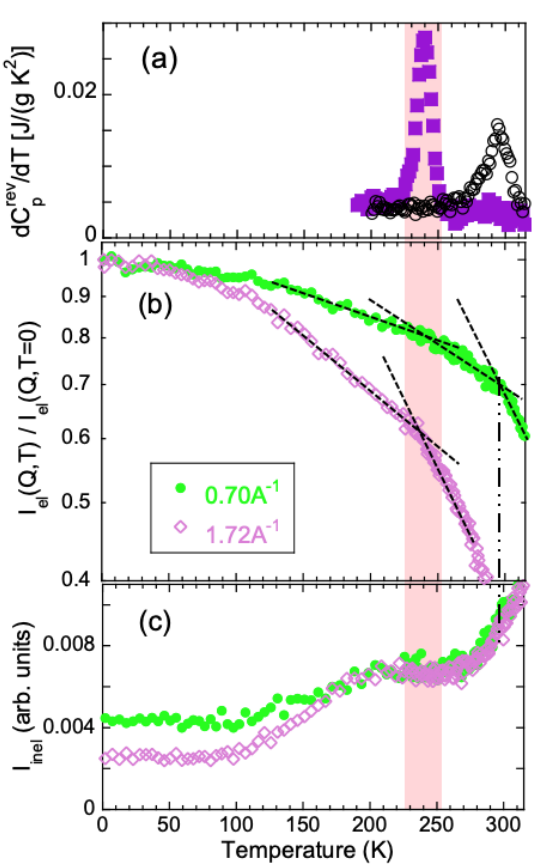
Fig. 5. Temperature dependence of results on the blend with 0.20 resin weight fraction in deuterated SBR: (a) temperature derivative of the specific heat; (b) elastic intensity normalized to its extrapolated value at T =0; (c) inelastic intensity at 2 µ eV. Neutron scattering results correspond to the two Q -values indicated. Red area covers the calorimetric glass-transition